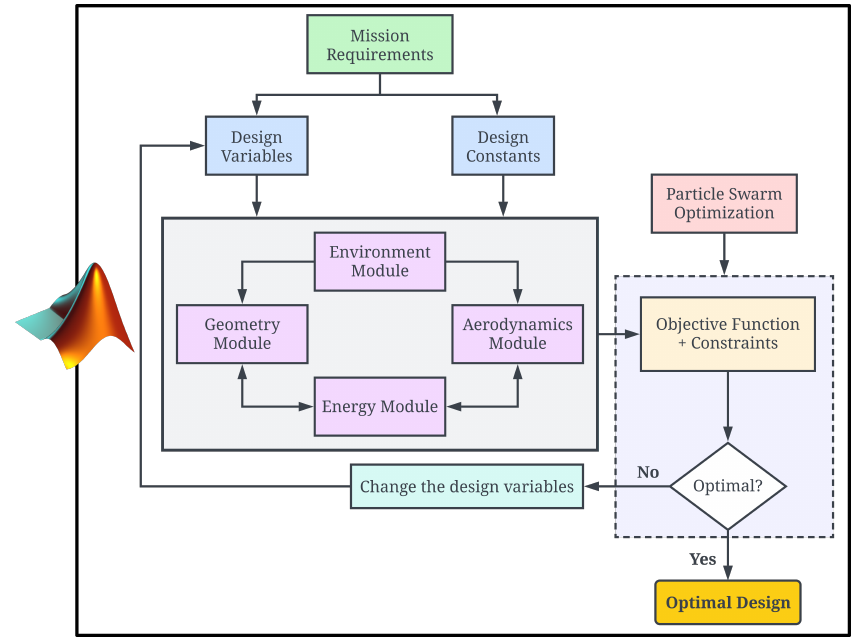
Figure 4. Multidisciplinary design optimization